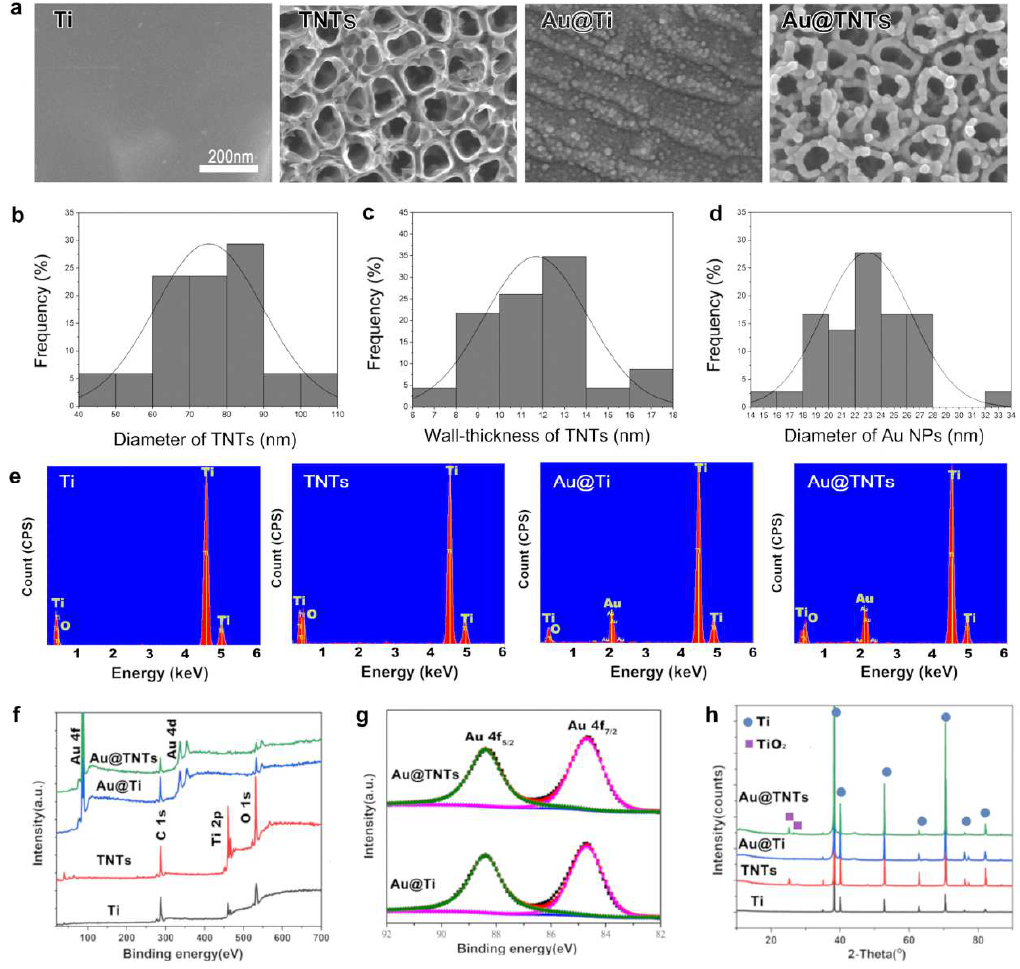
Figure 2. ( a ) SEM images of Ti, TNTs, Au@Ti and Au@TNTs samples. ( b ) Diameter distribution of TNTs. ( c ) Wall-thickness distribution of TNTs. ( d ) Diameter distribution of Au NPs on Au@TNTs sample. ( e ) EDS and ( f ) XPS spectra of Ti, TNTs, Au@Ti, and Au@TNTs samples. ( g ) High-resolution XPS spectra of Au for Au@Ti and Au@TNTs samples. ( h ) XRD spectra of various samples.